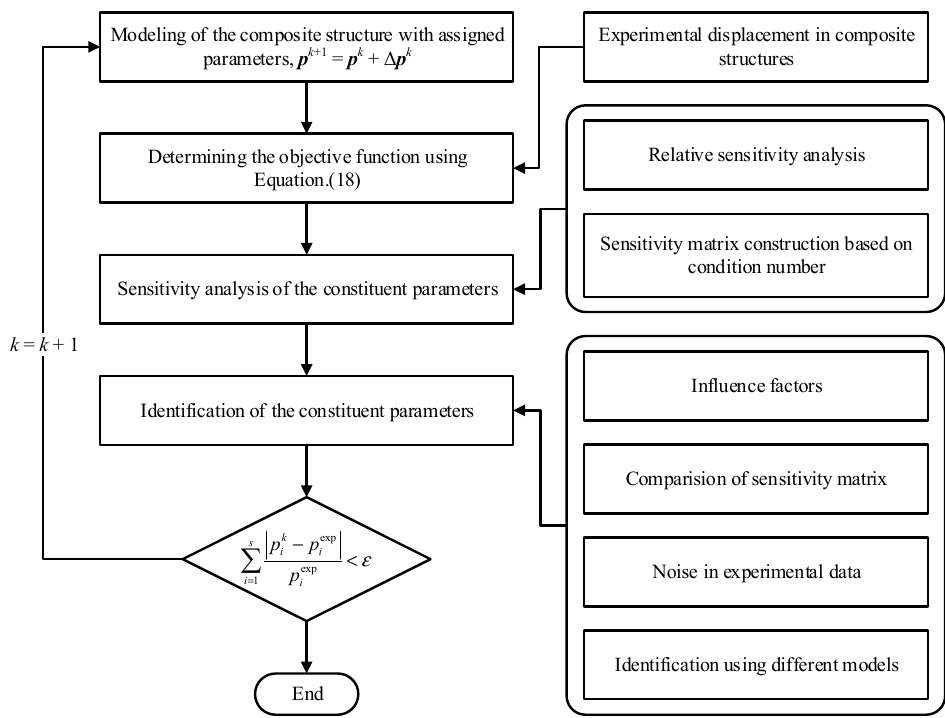
Figure 2. Flowchart of the constituent parameter identification method for composites.